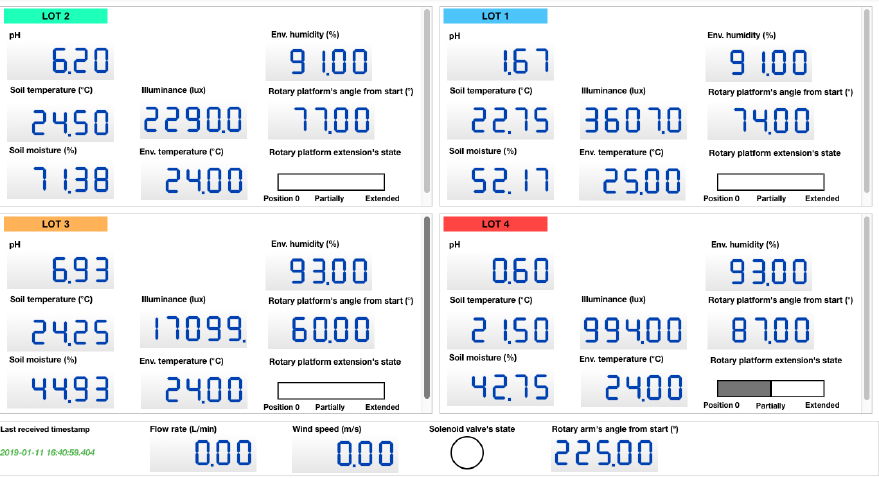
Figure A3. Implemented IoT platform real-time dashboard.